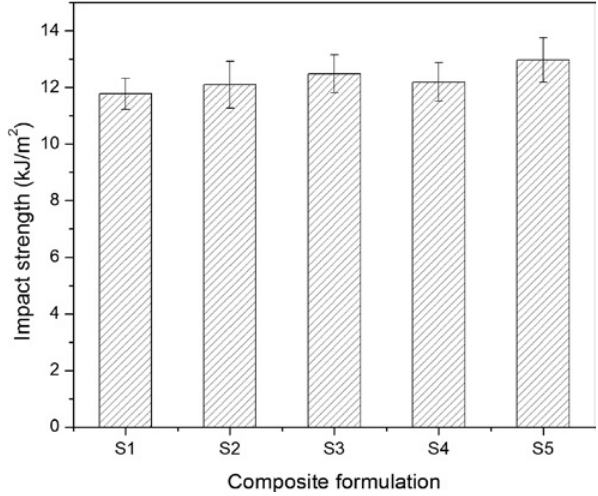
Figure 7: Impact strength of the composites.